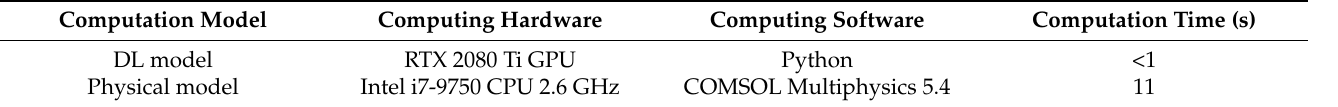
Table 2. Computation ability between DL model and physical